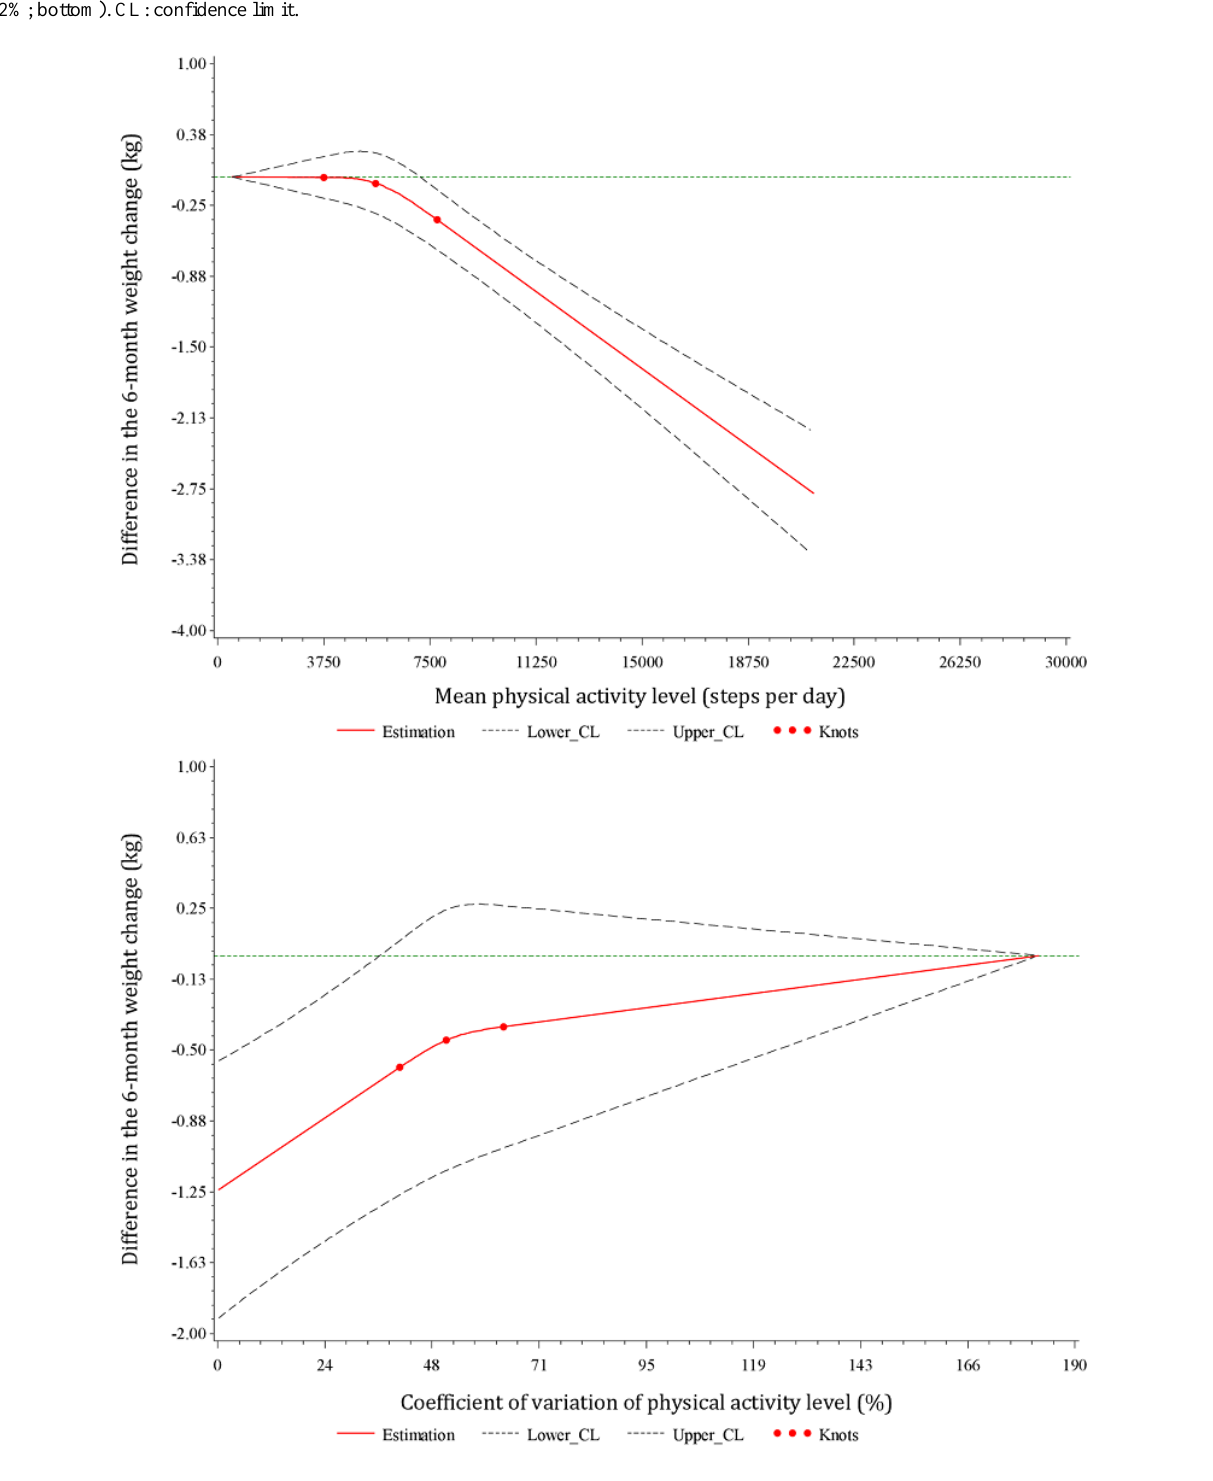
Figure 3. Relationships between mean physical activity level and the variability in physical activity level and 6-month weight change fitted with restricted cubic splines (3 knots placed at the 25th, 50th, and 75th percentiles). The solid red line represents the mean differences; the dashed lines are the 95% confidence limits; the green straight horizontal line corresponds to the line, y=0. The y-axis represents the difference in the 6-month weight change between individuals with any value of mean physical activity level (top) or physical activity level coefficient of variation (bottom) with individuals with the minimum value of mean physical activity level (516 steps/day; top) or with the maximum value of physical activity level coefficient of variation (182%; bottom). CL: confidence